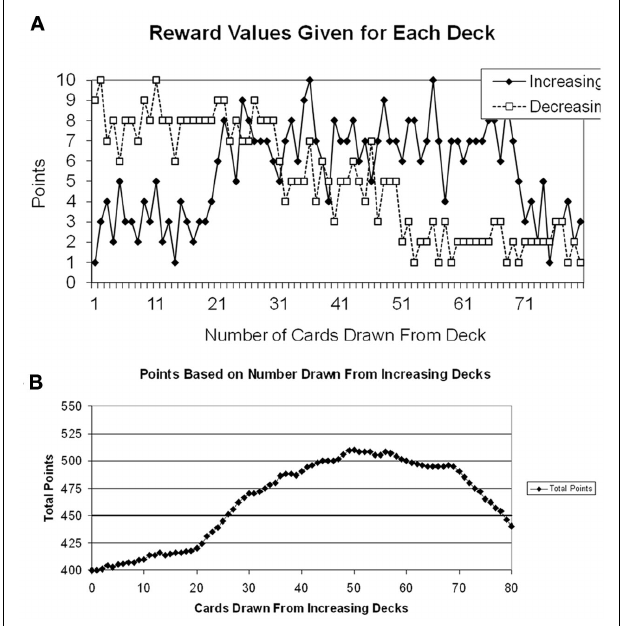
FIGURE 3 | (A) Reward structure for the choice-dependent task. Points given were based on how many times participants had drawn from each type of deck. Separate counters were kept for the increasing and decreasing decks. (B) Plot of the points participants would earn based on the number of draws from the increasing